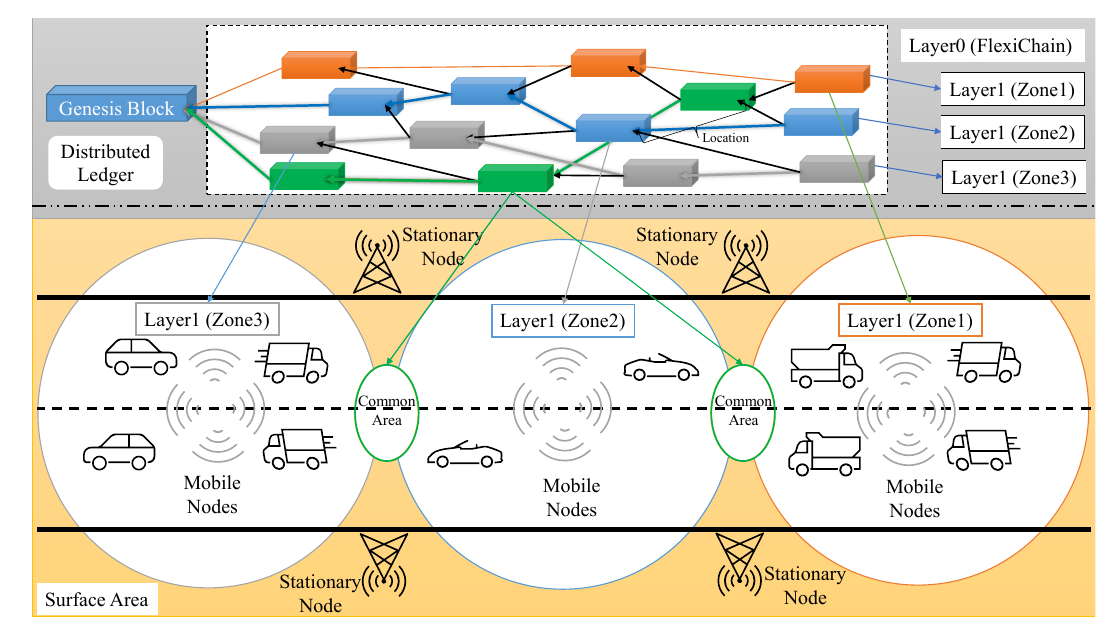
Figure 4. Zones and Their Corresponding FlexiChain Ledger.